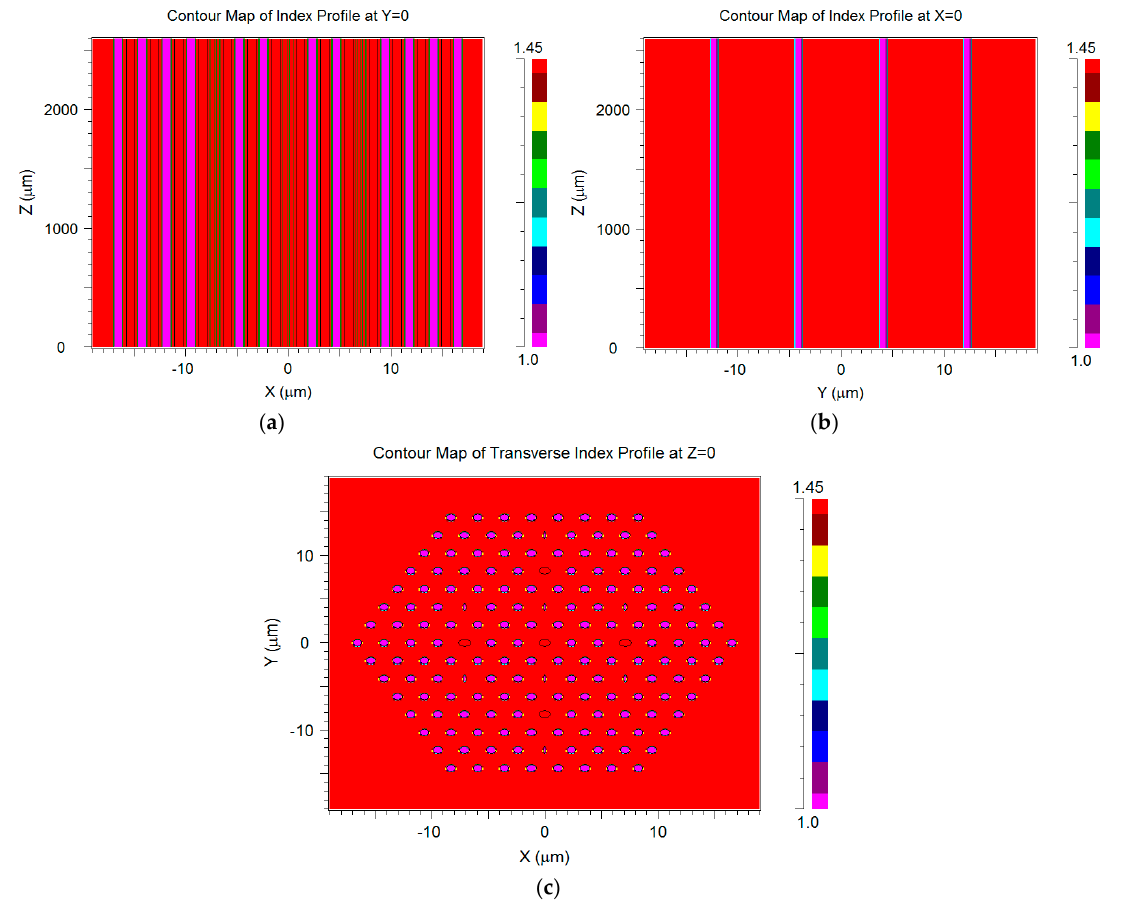
Figure 2. Refractive index profiles of the 4 × 1 power combiner: ( a ) xz plane at y = 0; ( b ) yz plane at x = 0; ( c ) xy plane at z = 0.